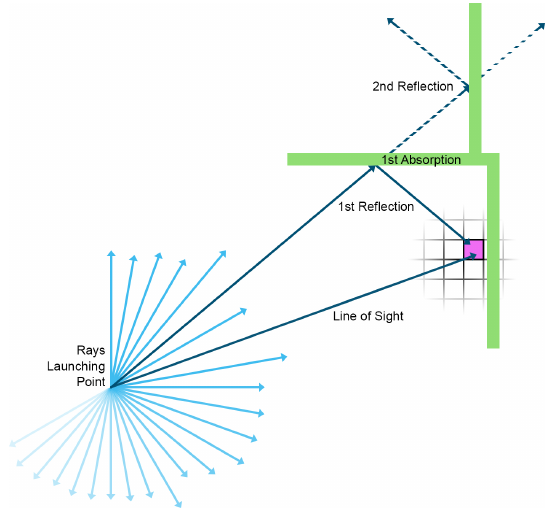
Figure 6. Ray Launching and Tracing Example (ground truth). After that, the signal transmission from the nodes at the P n positions will be iteratively simulated, testing through an optimization algorithm different coefficients. In the end, the optimal combination of coefficients would be the one that minimizes the aggregated error at the P s positions, between the simulation and the ground truth.